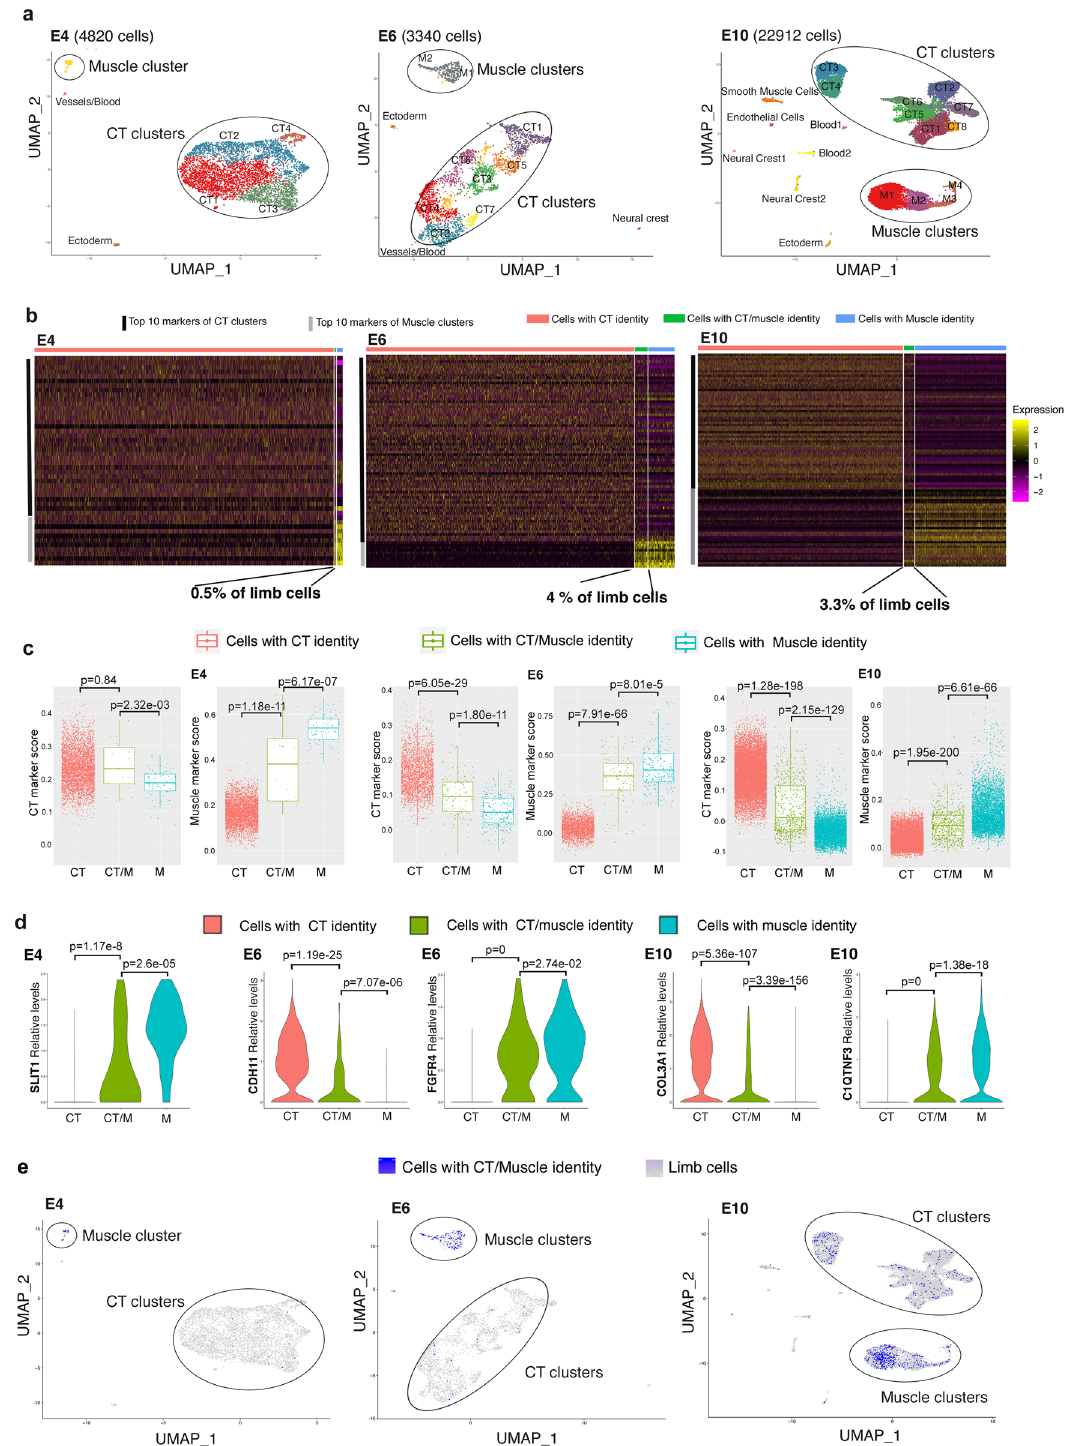
suggesting that the transition process starts before E6 by